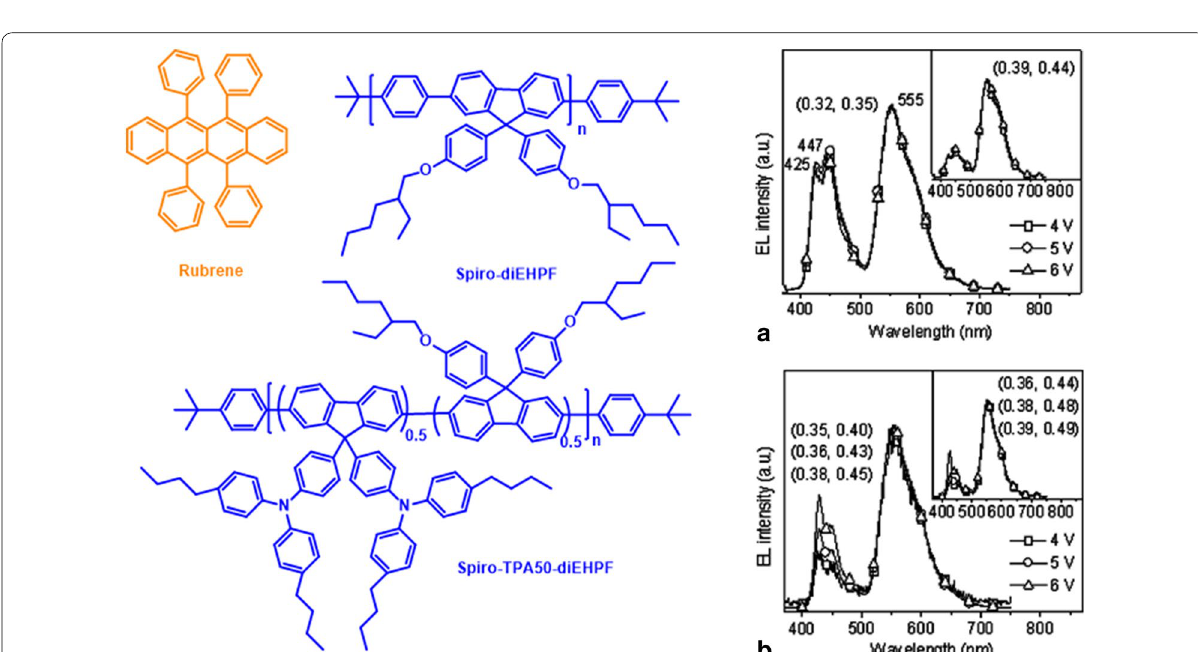
Fig. 2 Chemical structures of rubrene and polymers. EL spectra of a rubrene-doped spirodiEHP (0.35 wt%) and b spiro-TPA50-diEHP devices. The insets in a and b EL spectra of rubrene-doped devices (0.5 wt%) (Reproduced with permission from Ref. [17] Copyright 2007, ©Applied Physics